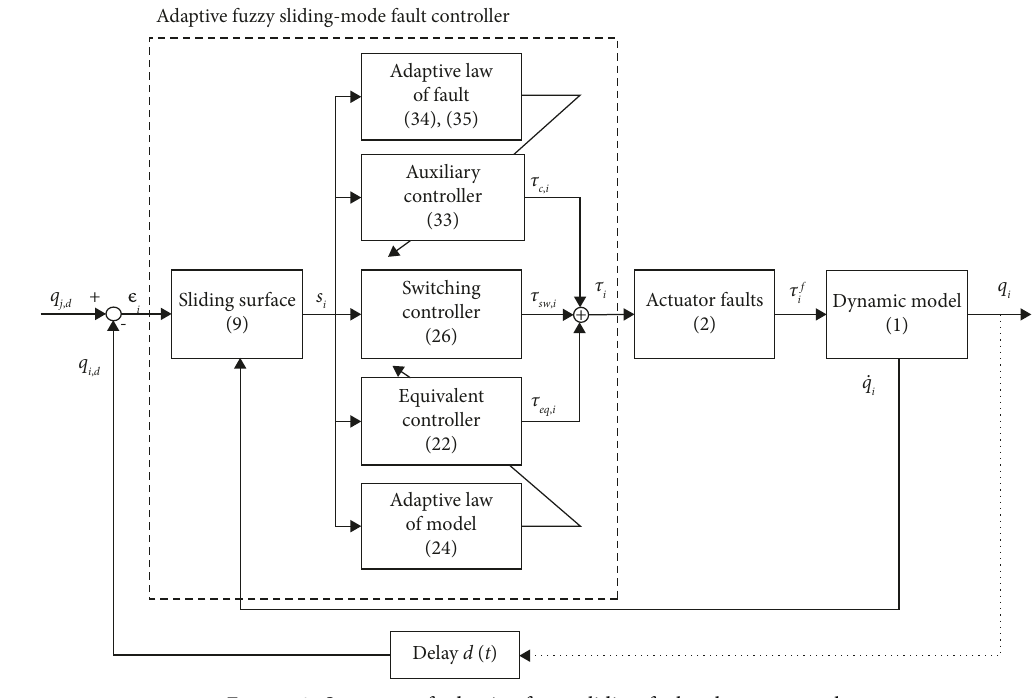
Figure 2: Structure of adaptive fuzzy-sliding fault-tolerant